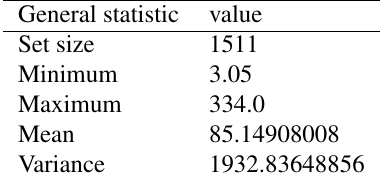
Table 1. Statistics of data sets.